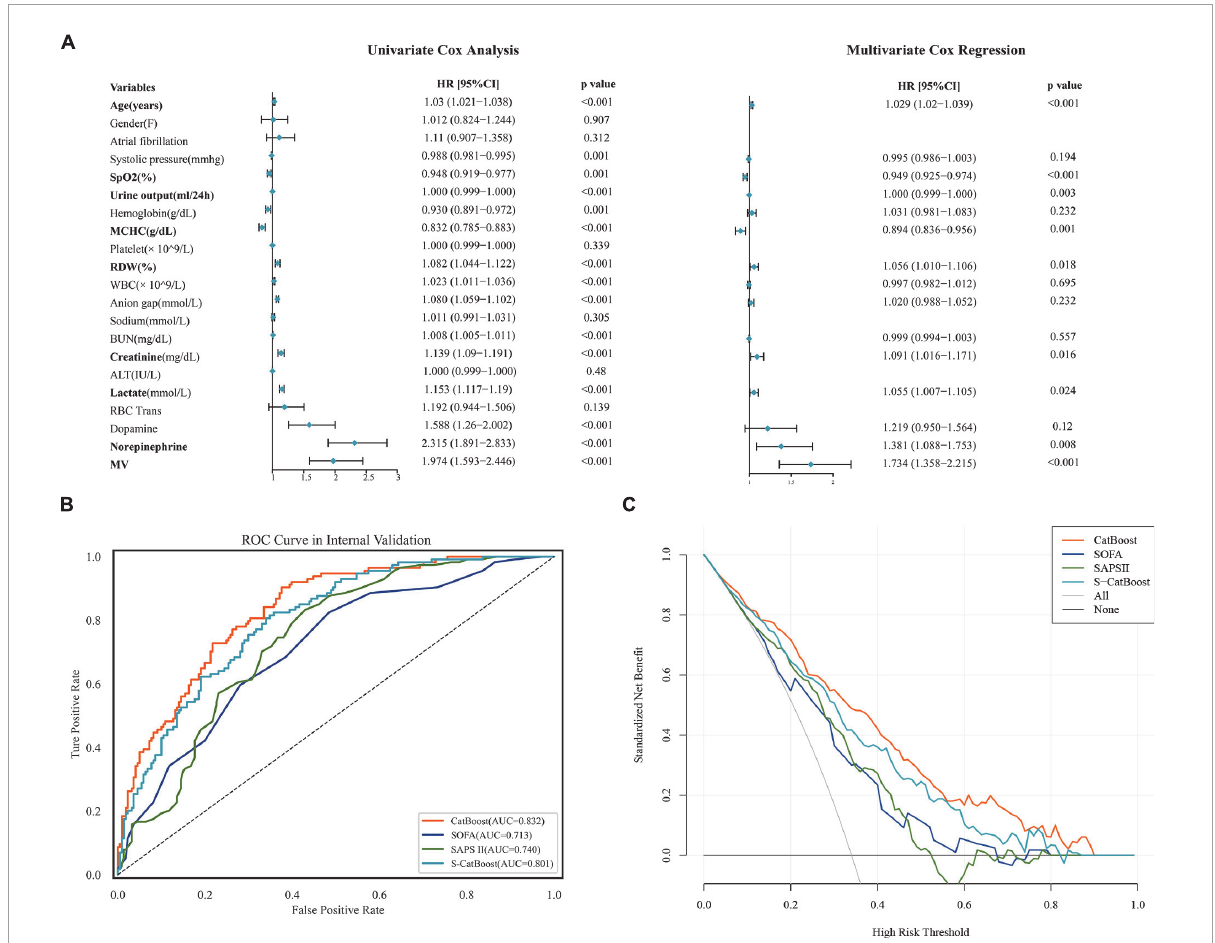
FIGURE4 Model development and performance for S-CatBoost. (A) Univariate and multivariate Cox analyses of 21 features used to construct model; (B) ROC curve of CatBoost, S-CatBoost, SAPS II score, and SOFA score in internal validation; (C) DCA curve of CatBoost, S-CatBoost, SAPS II score and SOFA score in internal validation. Catboost, Categorical Boosting; S-Catboost, simplified Catboost model; AUC, area under the curve; DCA, Decision curve analysis; SAPS II, simplified acute physiology score II; SOFA, SOFA Score; SPO2, saturation of pulse oxygen; MCHC, mean corpuscular hemoglobin concentration; WBC, white blood cell count; BUN, blood urea nitrogen; RDW, red blood cell distribution width; RBC trans, red blood cell transfusion; ALT, alanine transaminase; MV, mechanical